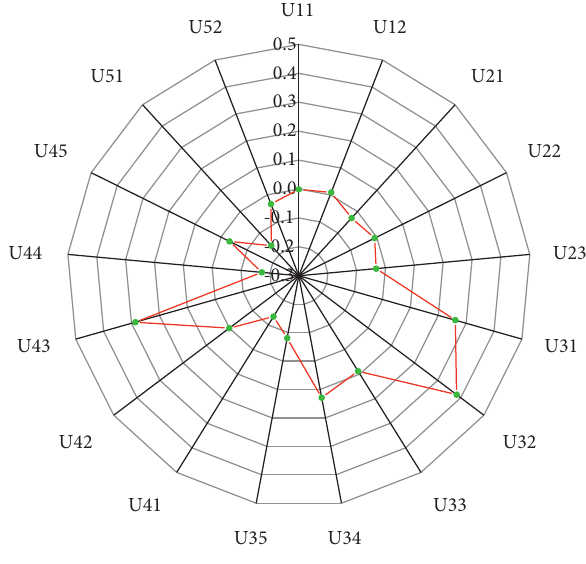
Figure 10: Closeness coefficient.